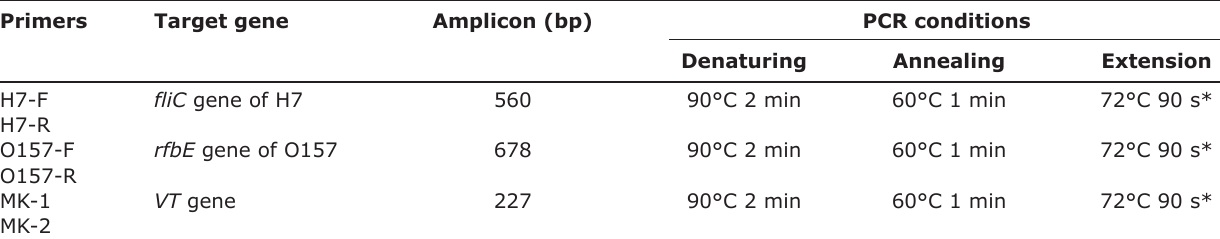
Table-2: The PCR primers and thermal cycling conditions used for the amplification of verotoxin-producing genes in Escherichia coli [18].